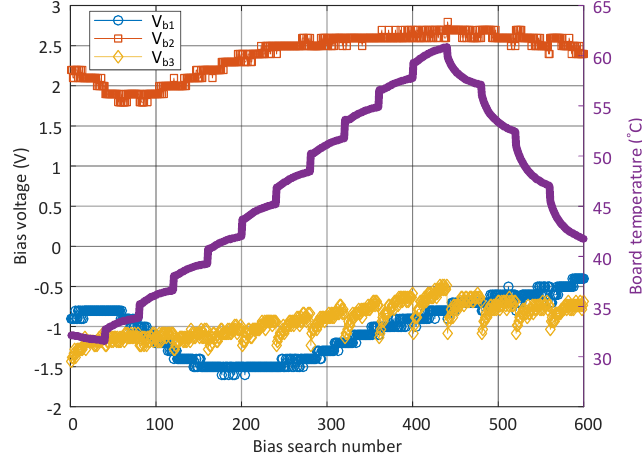
Figure 4. Searched bias voltages according to the temperature variation.